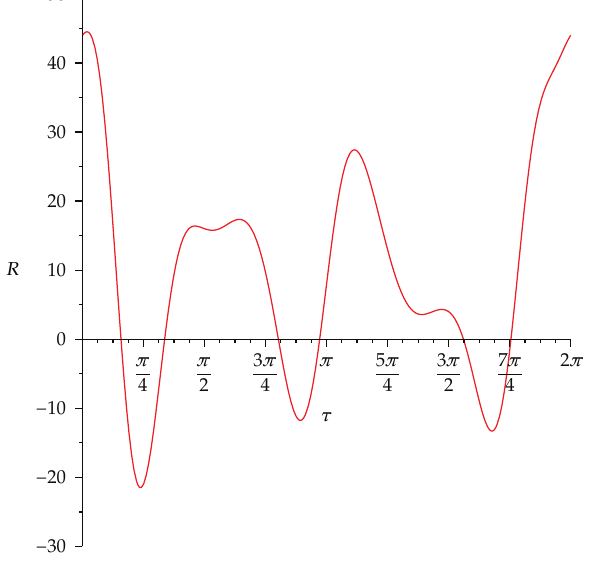
Figure 18: The evolution of the R with respect of the cosmic time τ for (cid:2) 4.12 (cid:3)